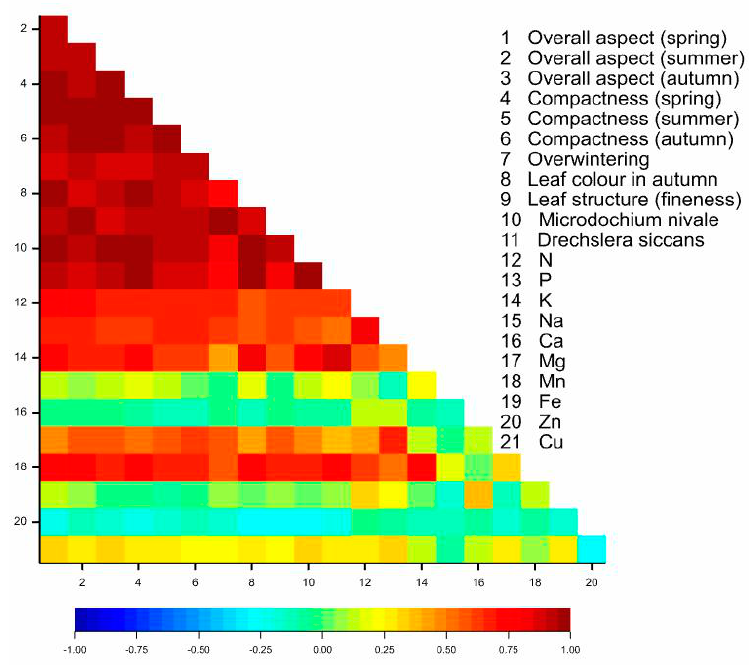
Figure 1. Heatmap for Pearson’s linear correlation coe ffi cients between observed traits ( r critical = 0.32).